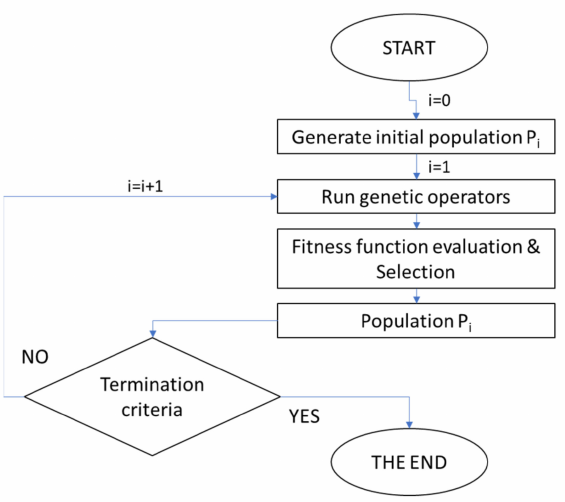
Figure 8. Genetic algorithm flowchart. Each population P(t) is composed by set of chromosomes representing design configu-